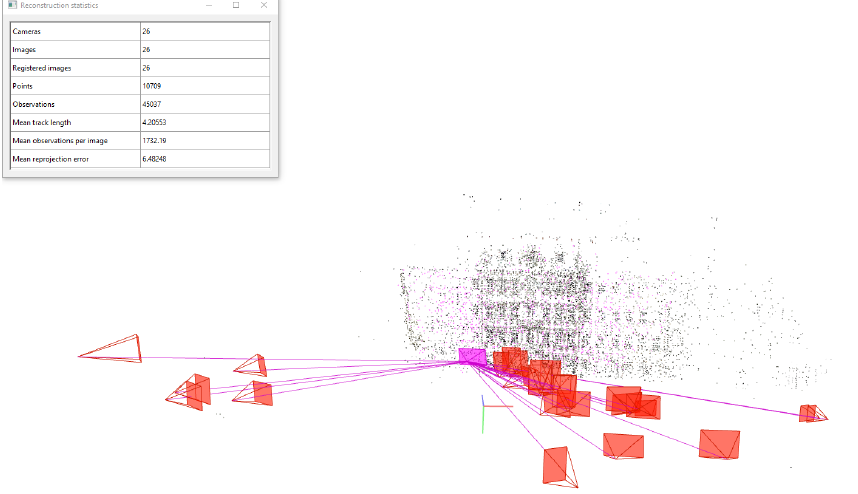
Figure 7. Final reconstruction in COLMAP showing the estimated camera positions of 26 photographs and drawings. The sparse point cloud consists of approximately 10,000